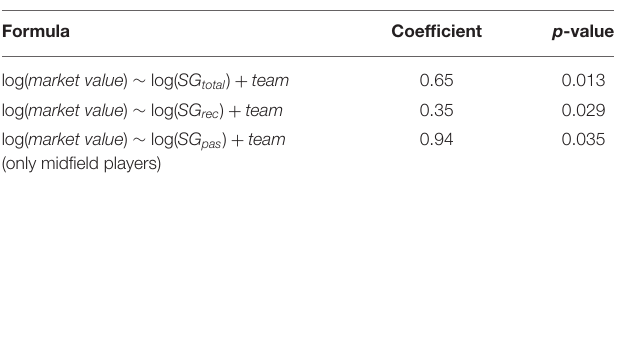
TABLE A1 | Linear model results for relationship between market values and SG